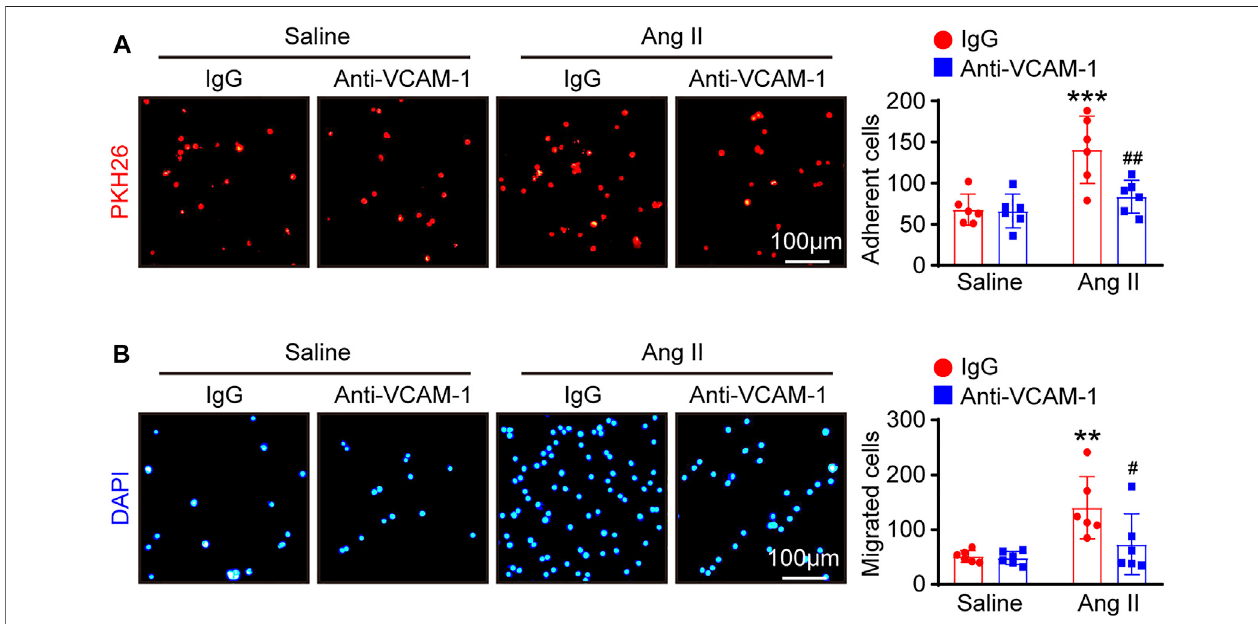
FIGURE 5 | Blockade of VCAM-1 suppresses Ang II-induced macrophage adhesion and migration to HUVECs in vitro . (A) HUVECs were pretreated with anti- VCAM-1 (5 μ g/ml) or IgG control for 4 h and then stimulated with saline or Ang II (100 nM) for 24 h. PKH-26 staining of macrophages (left, scale bar = 100 μ m) and analysisofadherentcells(right, n =6). (B) HUVECsweretreatedasdescribedin (A) .Macrophageswereaddedtotheupperchamber,andHUVEC-conditionedmedium wasaddedtothe lowerchamber ofaTranswell plate.DAPIstainingofmacrophages (left,scale bar =100 μ m) and analysisofmigrated cells (right, n =6). The data are expressed as the mean ± SD, and n represents the number of samples. ** p < 0.01 and *** p < 0.001 versus saline; # p < 0.05 and ## p < 0.01 versus Ang II +